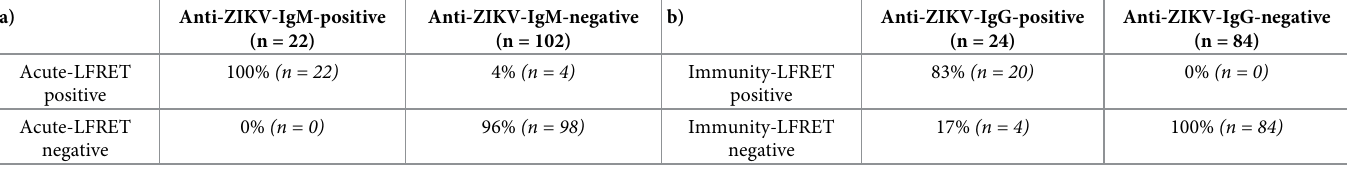
Table 4. Test outcomes when using non-rigorous sample inclusion